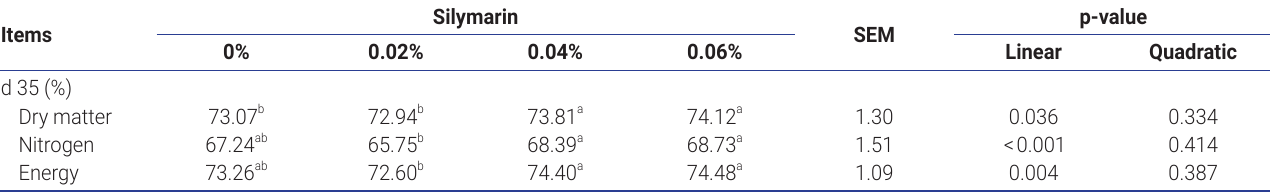
Table 3. The effect of silymarin supplementation on the nutrient digestibility in broilers